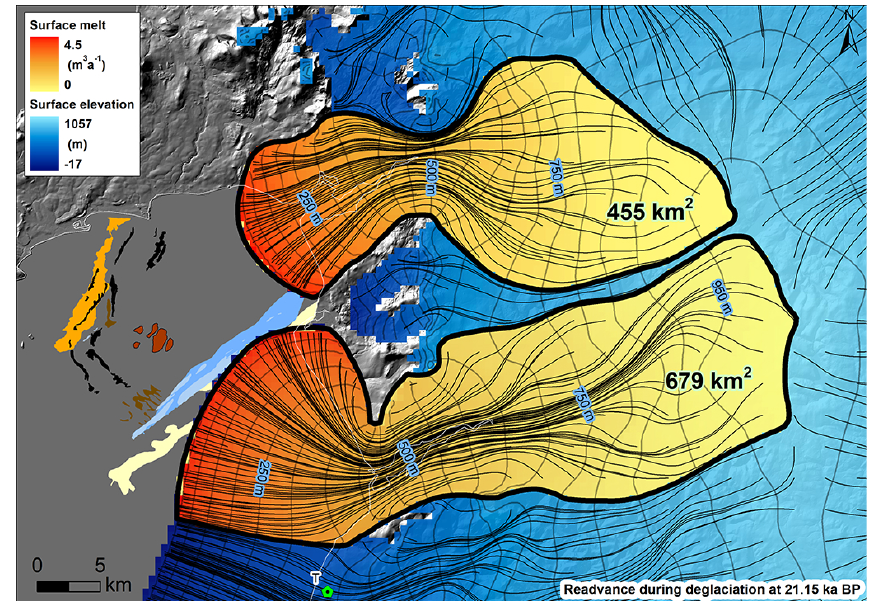
Figure 6. State of the modelled Welsh Ice Cap while readvancing during deglaciation at 21.15kaBP. Areal extents of the Tremadog (north- ern) and Mawddach (southern) Glacier catchments are highlighted. A coastal section at Tonfanau (T) records Irish Sea-sourced diamicton overlying a till of distinct Welsh